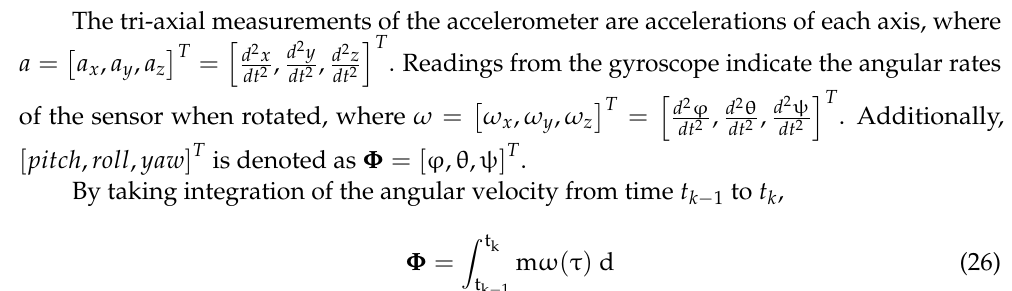
Figure 6. MPU 9250 and its coordinate system with Euler angles. Reprinted from [27] with permis- sion.